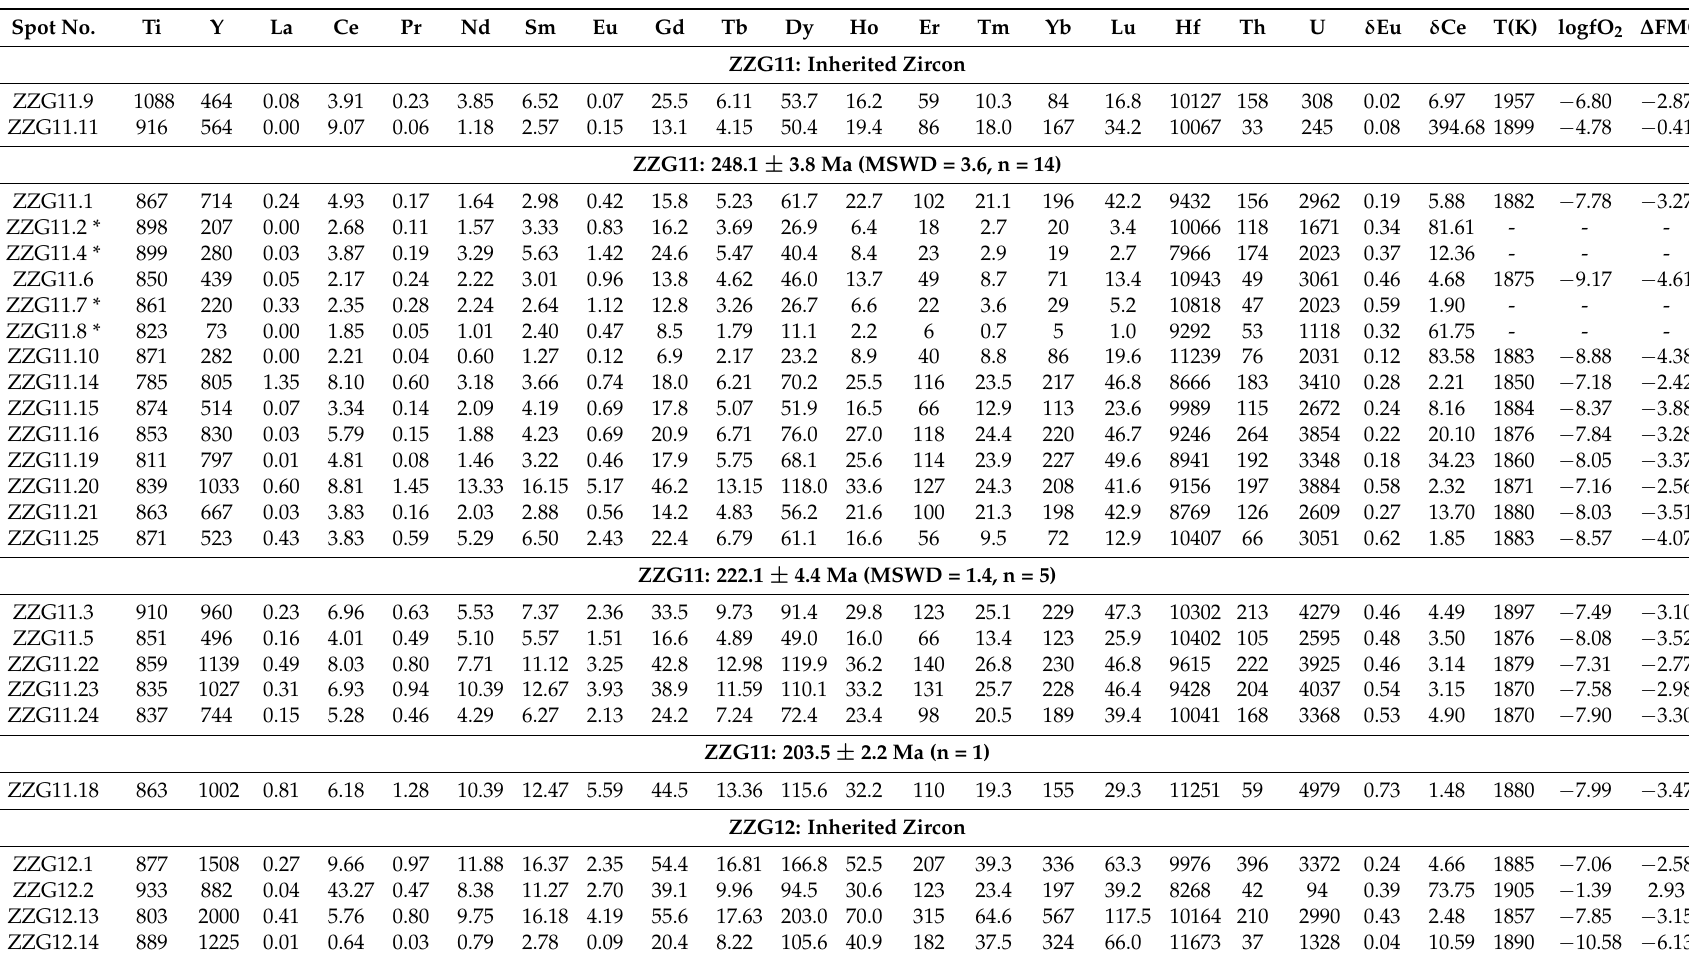
Table 2. Trace element concentration, and calculated Ti-in-zircon temperatures (T), logarithmic oxygen fugacity (logfO 2 ), and ∆ FMQ of zircons from the porphyritic dacite samples ZZG11 and